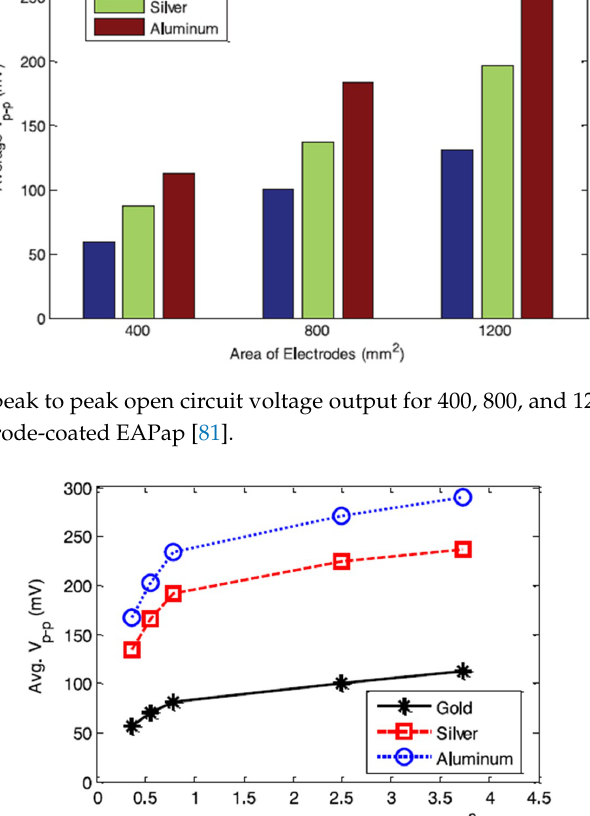
Figure 18. Variation of the average V p-p against the input acceleration amplitude (g rms ) for three parallel connected electrodes with an area of 1200 mm 2 [81].